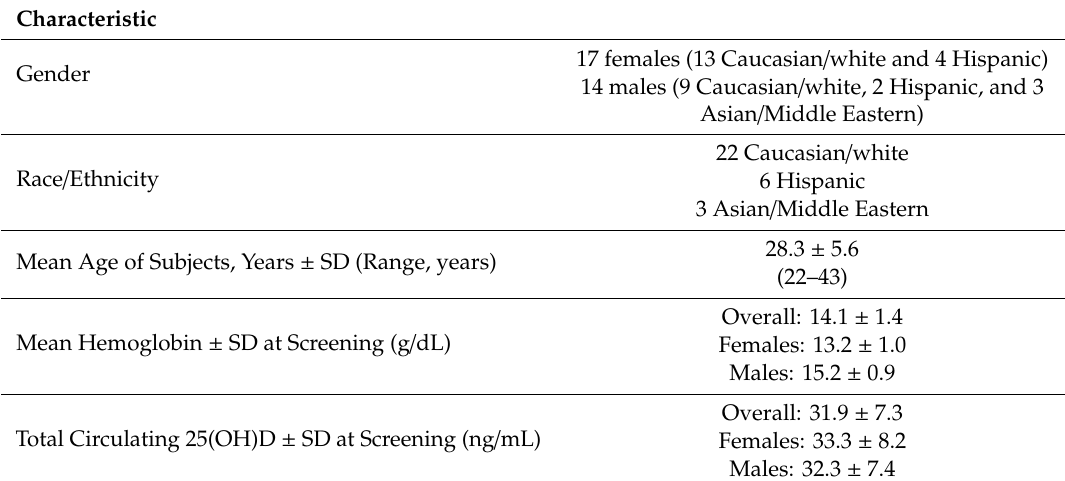
Table 4. Participant sociodemographic and clinical characteristics in study 2 ( n =